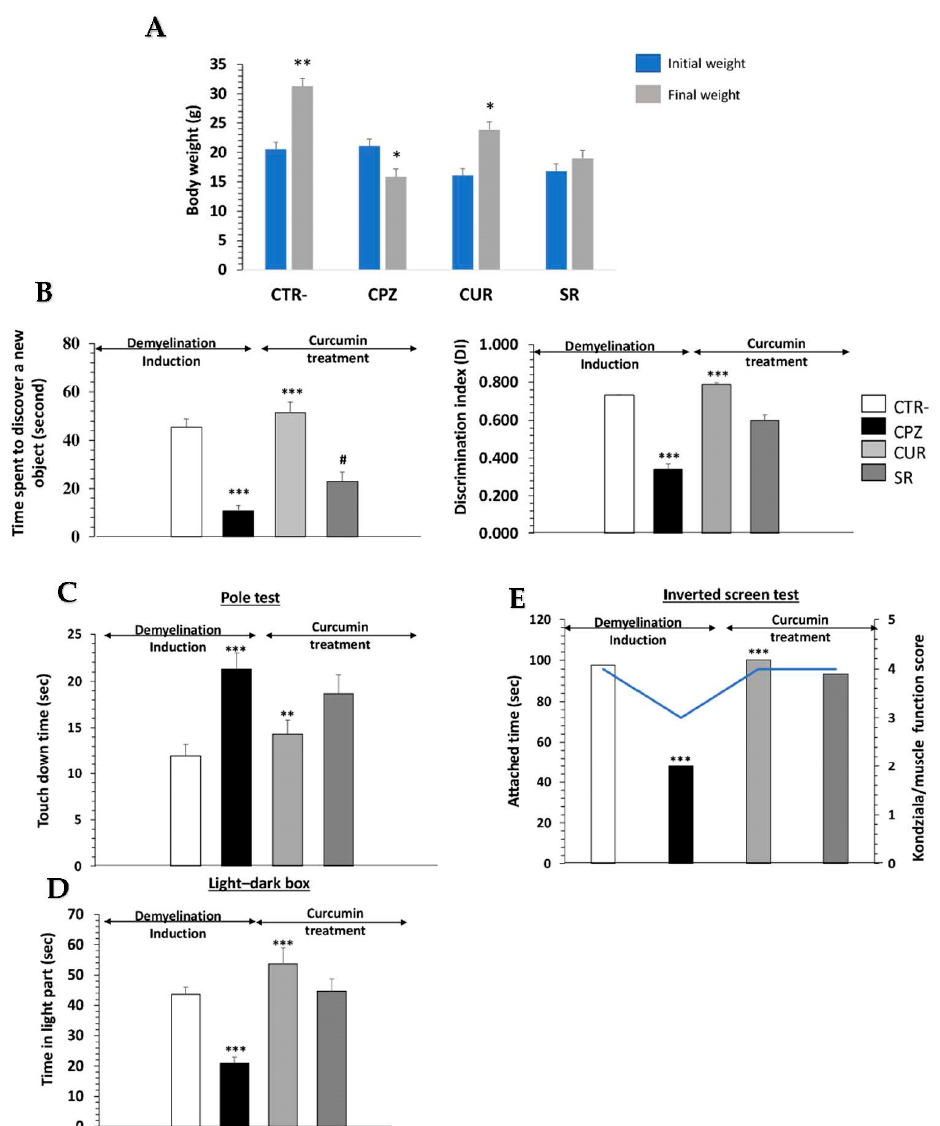
Figure 6. Effect of curcumin on cuprizone-induced behavioral changes in mice. ( A ) Body weights of animals in experimental groups at the beginning and end of experimentation, as well as during the study. Performance of animals in different cognitive tasks including novel object discrimination ( B ), pole ( C ), light/dark box ( D ) and inverted screen ( E ) tests. One-way ANOVA followed by Tukey’s multiple comparison test; */# p < 0.05, ** p < 0.01 and *** p < 0.001. *** p < 0.001 shows significant differences between negative control and cuprizone groups. ** p < 0.01 and *** p < 0.001 show significant differences between cuprizone and curcumin-treated groups.